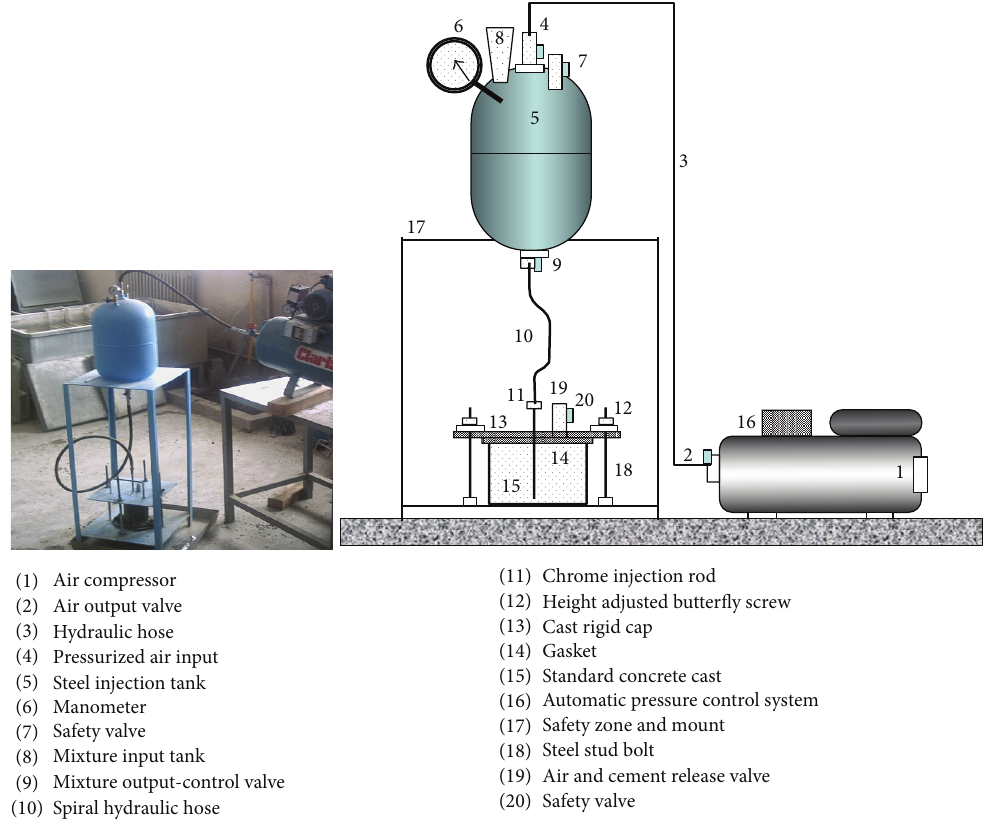
Figure 1: Experimental